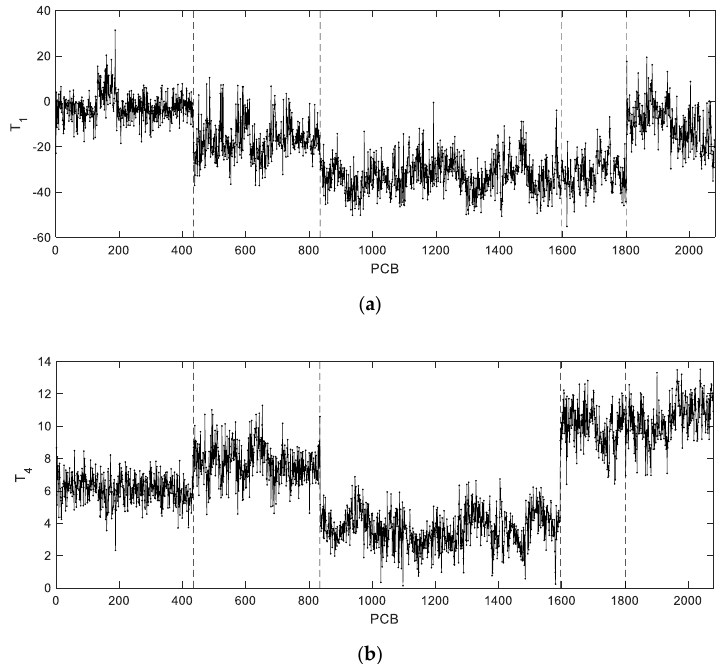
Figure 11. Principal components of CS2: ( a ) first principal component; ( b ) fourth principal component.